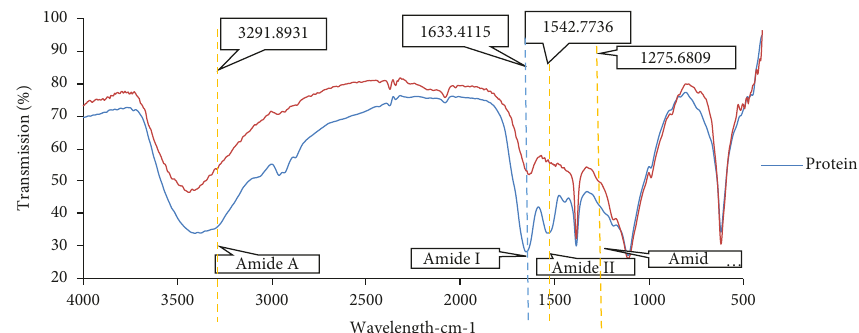
Figure 10: FT-IR of raw hoof and extracted keratin.